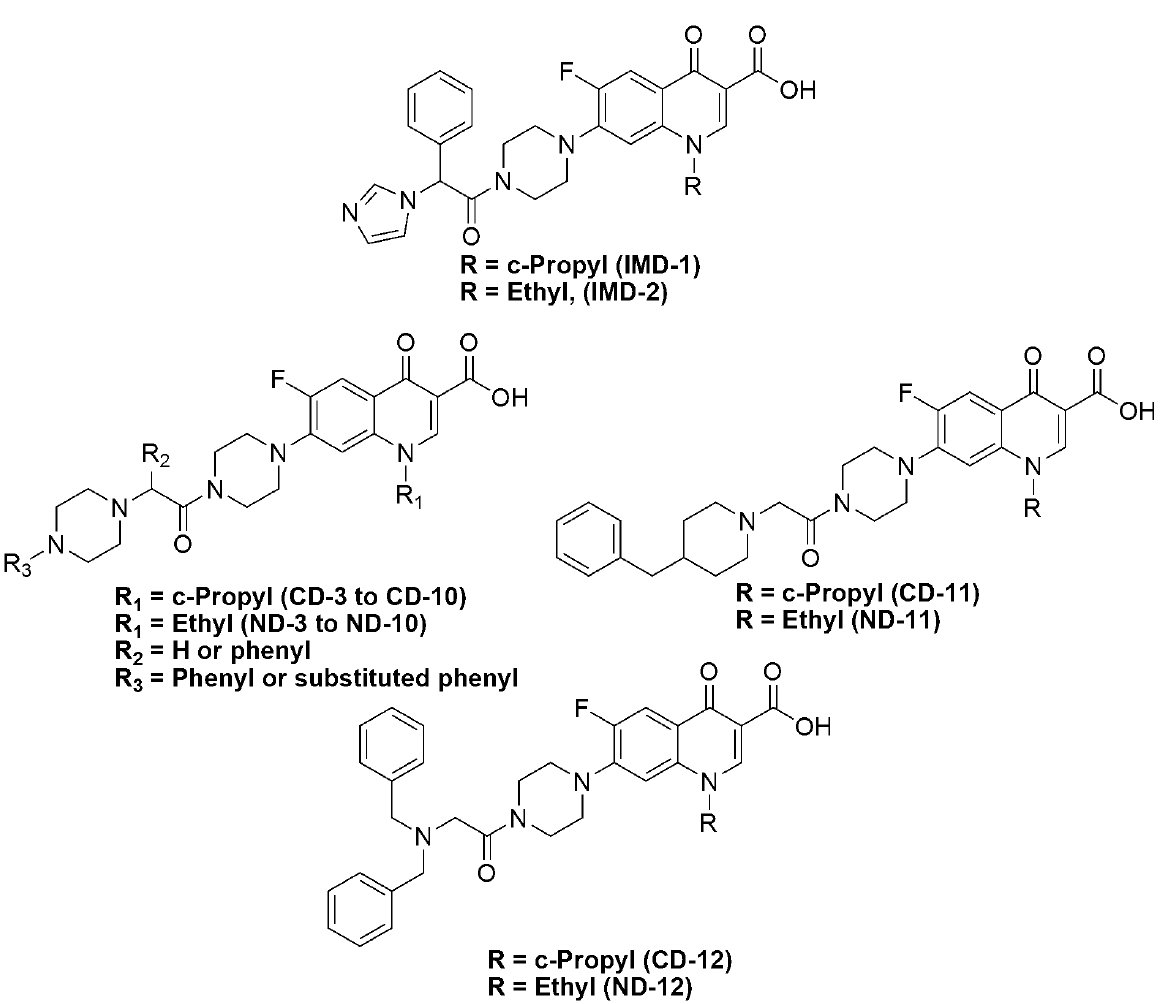
Figure 3. The general structures of the proposed